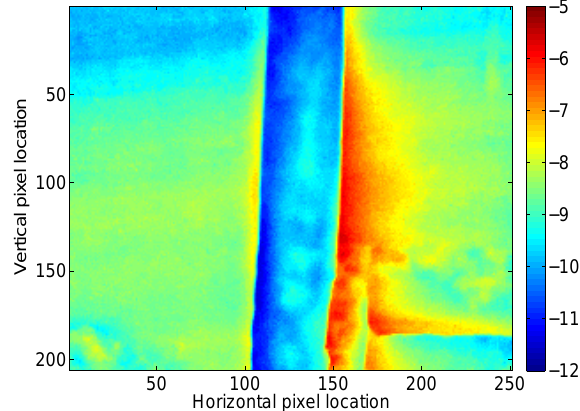
Fig. 9. Effect of cold air flow (from left to right). Relatively warm areas behind a convexity ( ∼ 5cm depth and ∼ 10cm width, similar to a specimen shown in Fig. 1b). Colorbar in ◦ C.